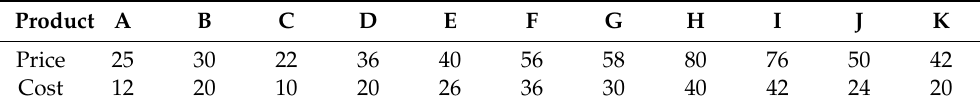
Table 1. Product list on the e-commerce platform. Product